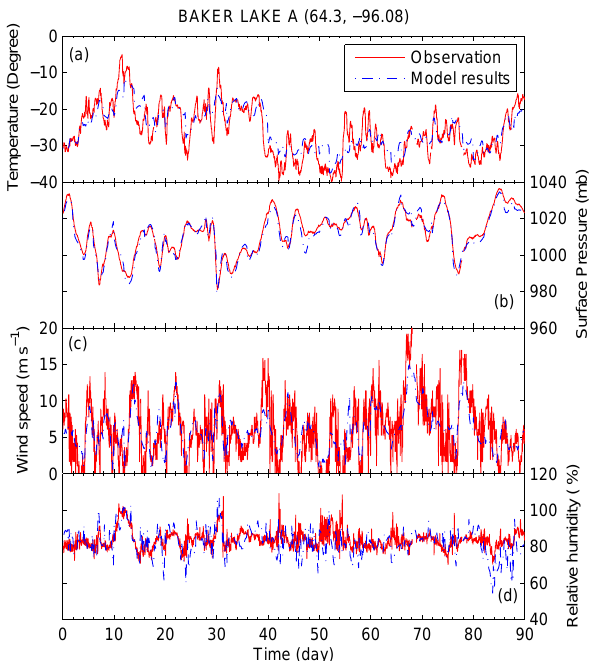
Fig. 4. Comparison of observed and simulated air temperature (a) , surface pressure (b) , wind speed (c) and relative humidity with re- spect to ice (d) at Baker Lake (64.3 ◦ N, 96.08 ◦ W) from December 2006 to February 2007.